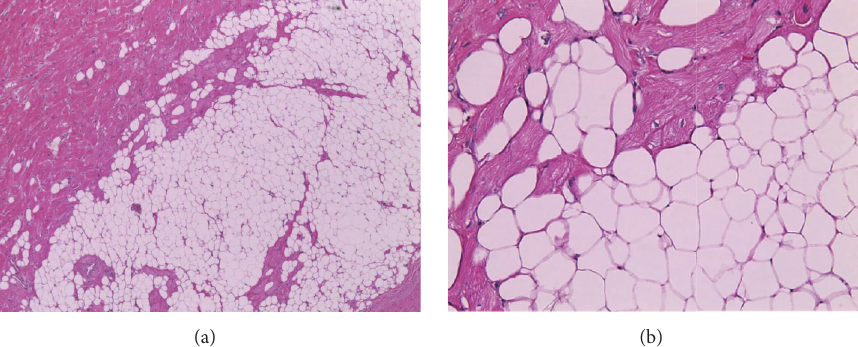
Figure 5: Adipose tissue interspersed with hypertrophic cardiac muscle, low power on the left (a) and high power on the right (b) demonstrating mature adipocytes with vacuolated